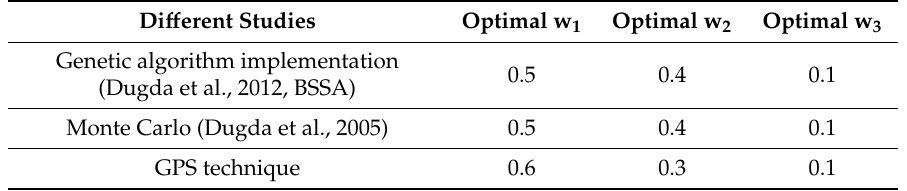
Table 3. Comparing optimal weights for seismic station ARBA from three di ff erent